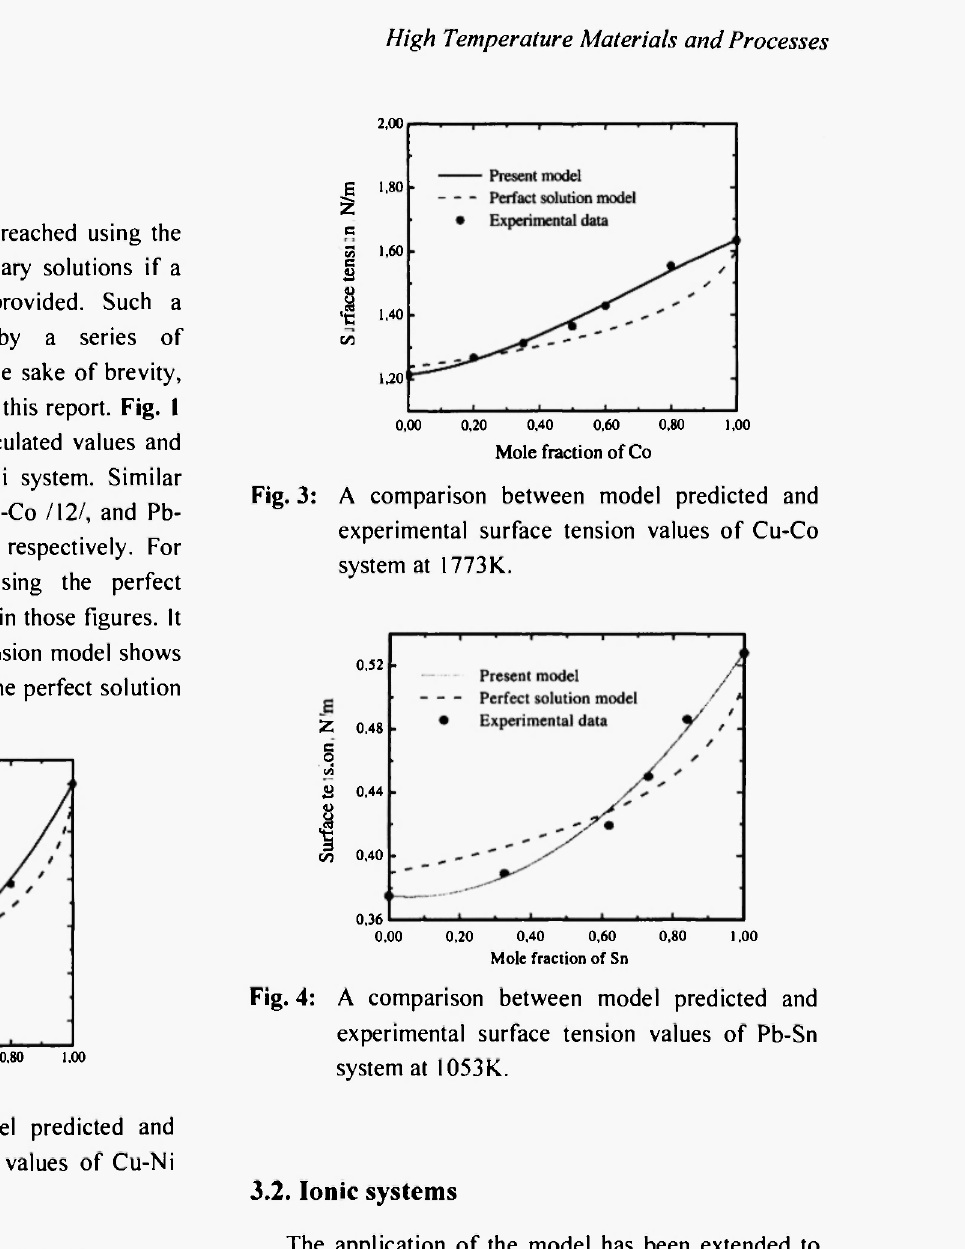
Fig. 1: A comparison between model predicted and experimental surface tension values of Cu-Ni system at 1773 Κ.